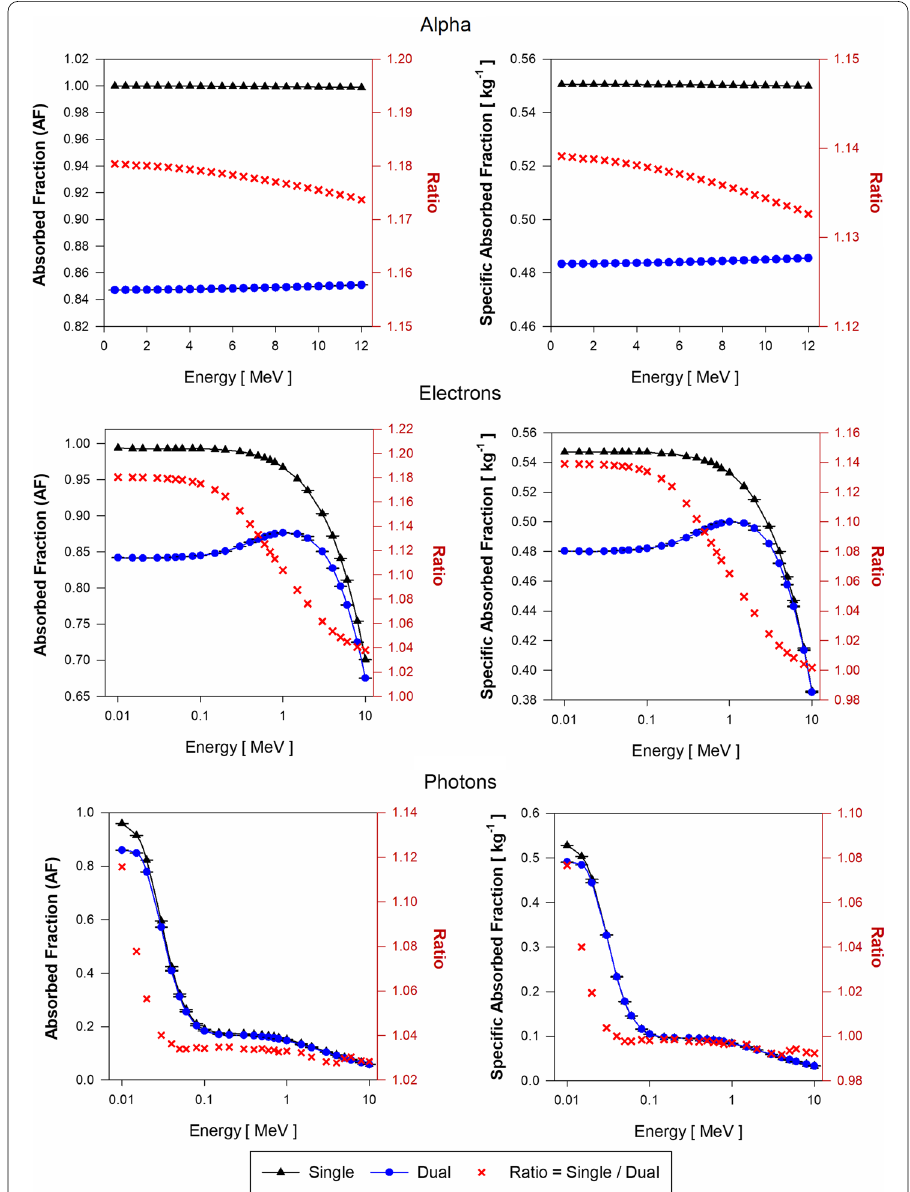
Fig. 7 Approximations of AF ( LP ← LB ) and SAF ( LP ← LB ) for monoenergetic alpha particles (Top), electrons (Center), and photons (Bottom) using the single‑region liver model (black triangles) and the dual‑region liver model (blue circles) in tetrahedral mesh‑type format for the reference adult female liver